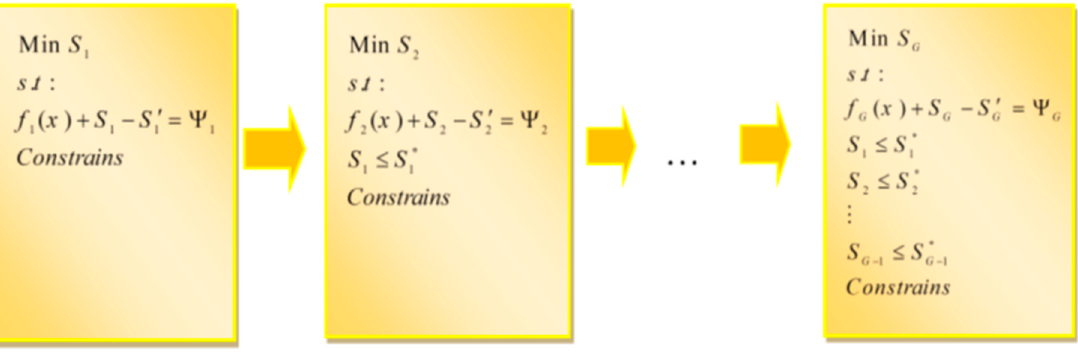
Figure 1. Sequential linear goal programming framework.